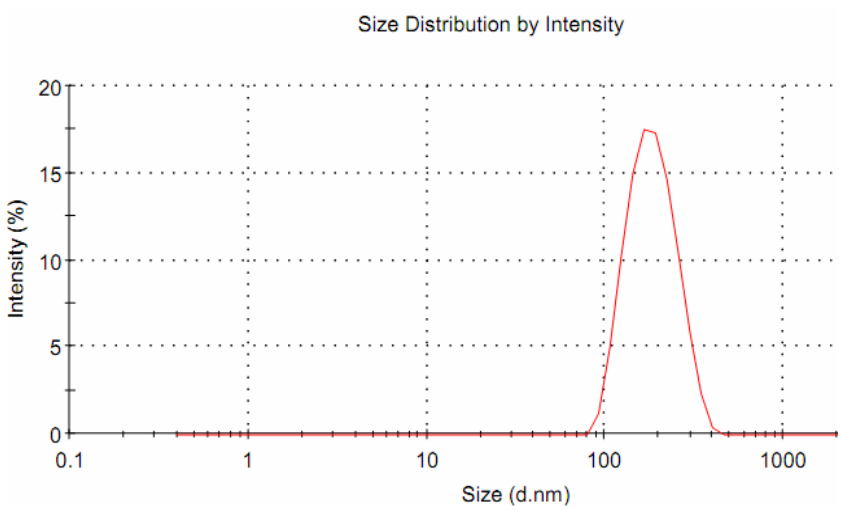
Pp micellar nanodispersion obtained by DLS 2